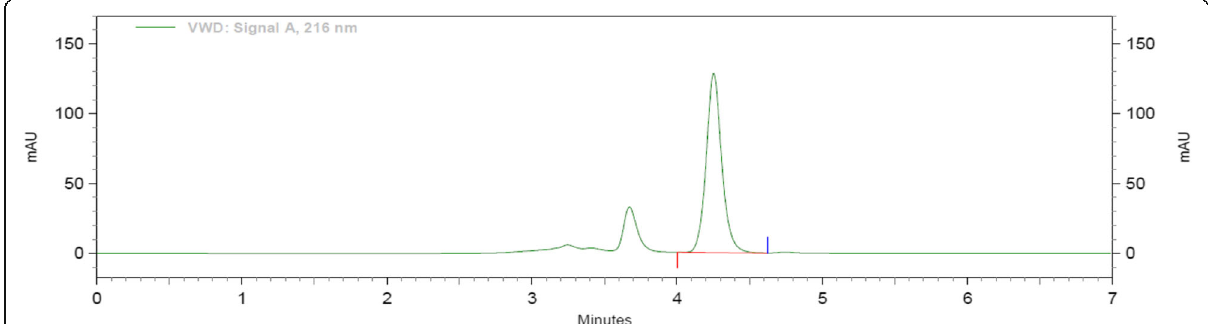
Fig. 4 Typical chromatogram obtained from optimized mobile phase